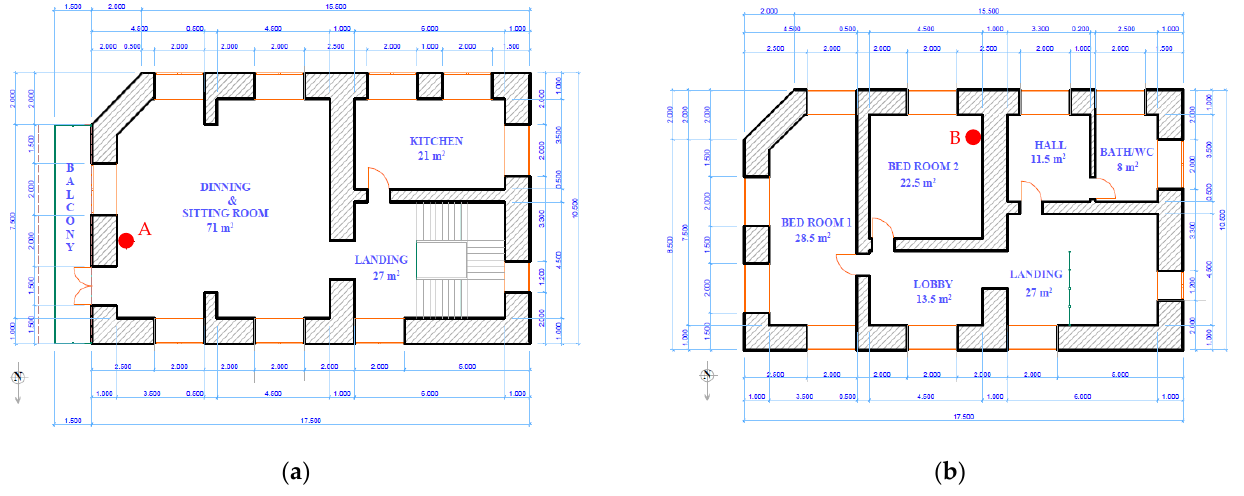
Figure 2. Floor plan for HRB1. The positions of the thermohygrometers are marked with red dots (Points A and B). ( a ) First floor, ( b ) Second